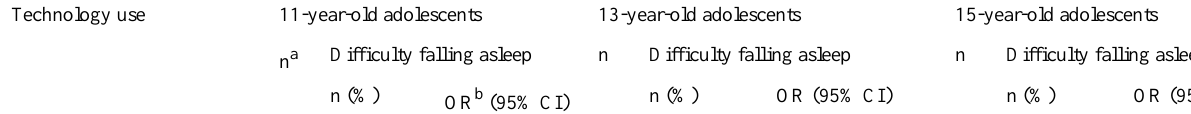
Table 2. Distribution of 3172 adolescents with sleep difficulties overall and by technology and social media use, with corresponding odds ratios and 95% CIs for age-specific samples (Lombardy,